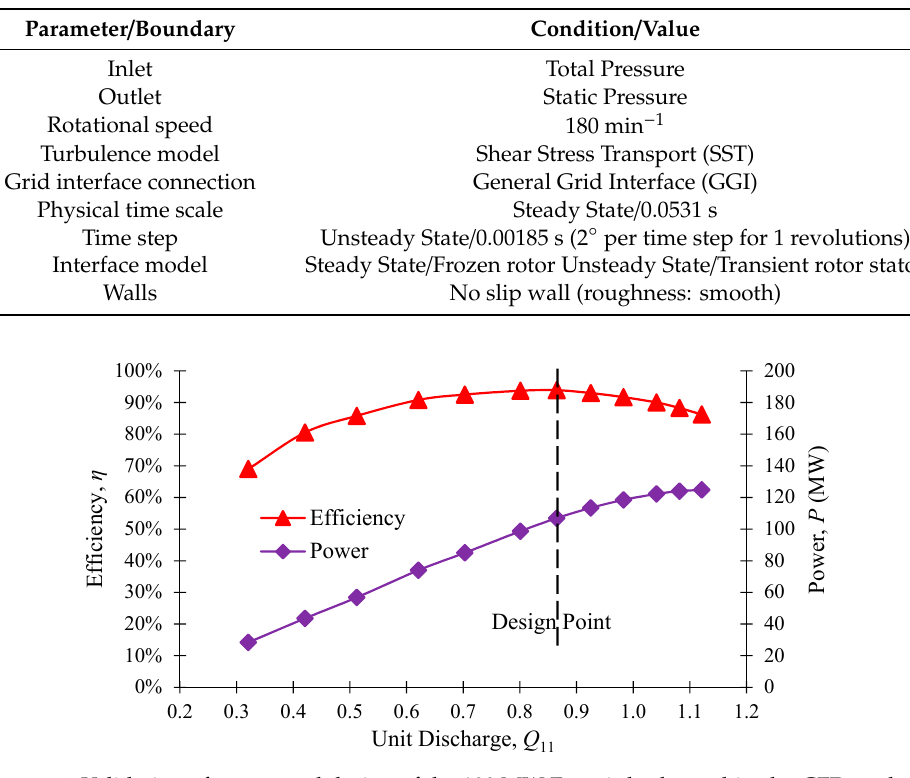
Figure 14. Validation of conceptual design of the 100 MW Francis hydro turbine by CFD analysis.